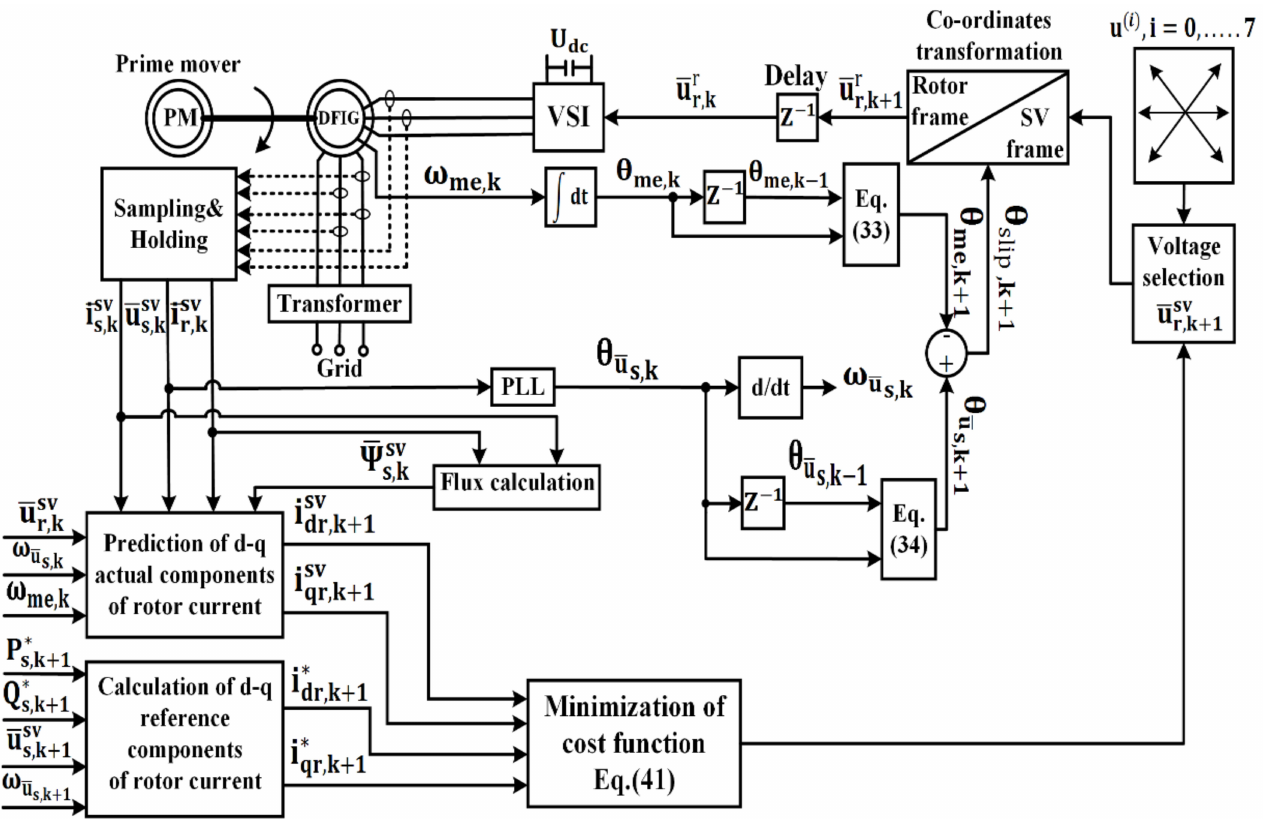
Figure 6. MPCC technique for the